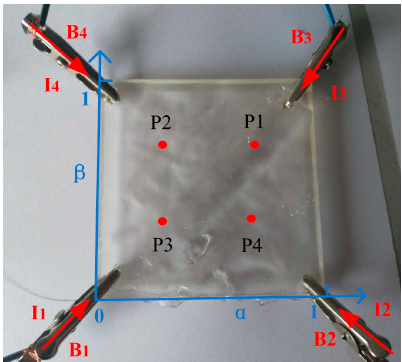
Figure 6. A square touch panel. Four driving signals were applied on the four corners of the panel. The panel was then divided into four sections B1–B4 with currents I1–I4 in corresponding sections. Normalized locations of four touch points P1–P4 (represented with round dots ) could then be calculated in the coordinate system indicated by the blue arrowed lines .